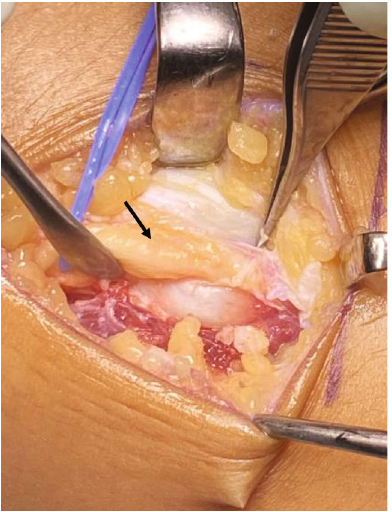
Figure 3: Peroneal nerve appearing compressed with adhesion caused by osteochondroma at the fi bular head and arching peroneus longus muscle fi bres (arrow: peroneal